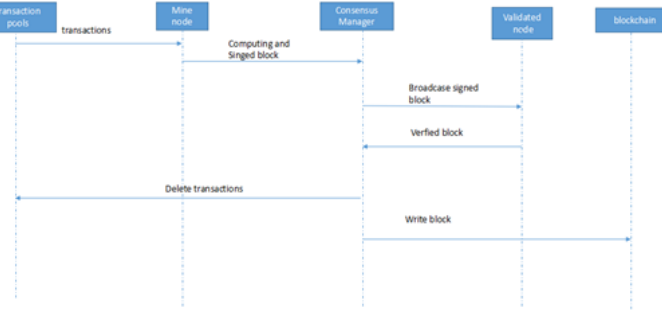
Figure 4. Data flow of the blockchain and IPFS manager. IPFS: InterPlanetary File